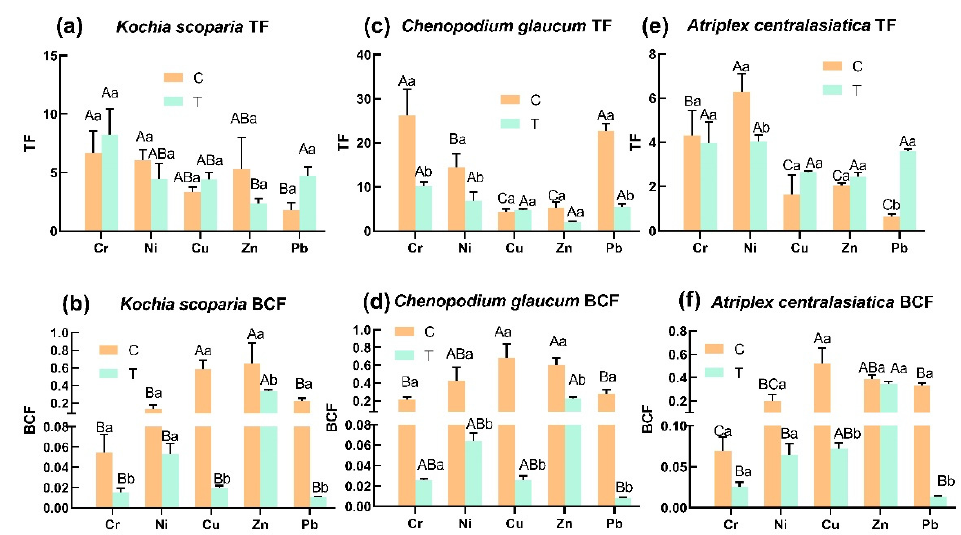
Figure 2. Enrichment of five heavy metals in three plant species. Bars indicate mean ± SD ( n = 3). Different capital letters indicated significant differences between groups (between different plants) and different lowercase letters indicate significant differences within groups (control and treatment of the same plant) using the Tukey test ( p < 0.05). C represents the control group; T represents the experimental group.